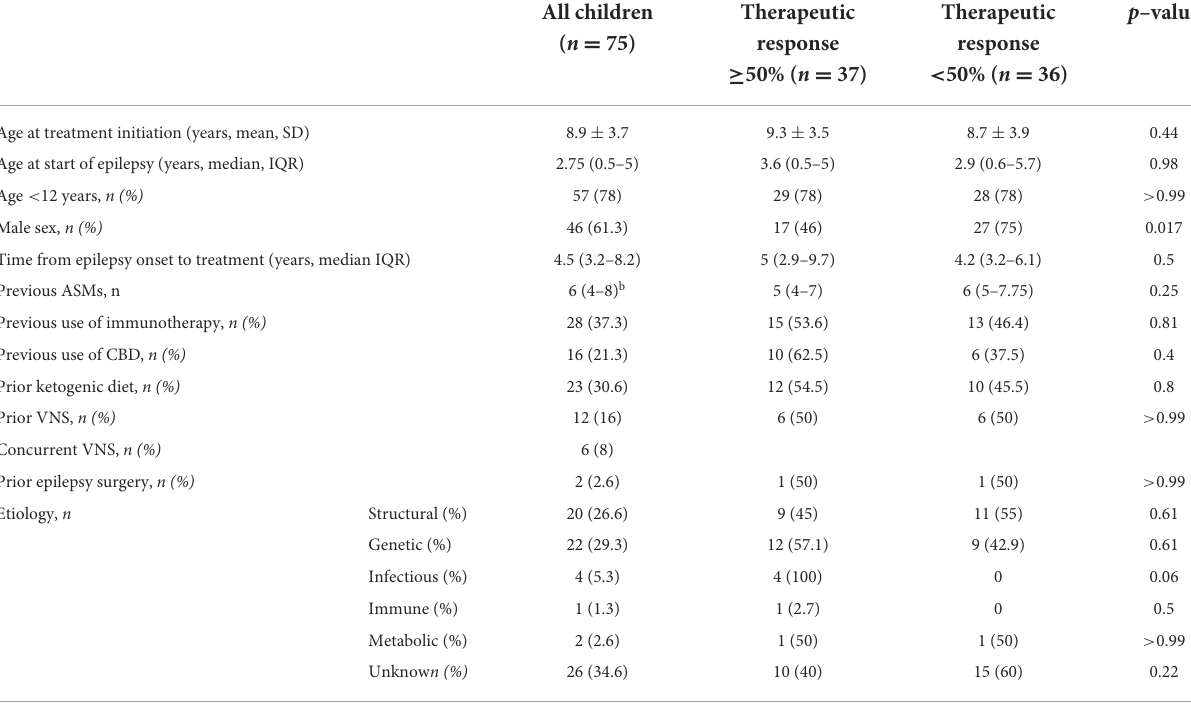
TABLE 1 Demographic data of responders and non-responders.